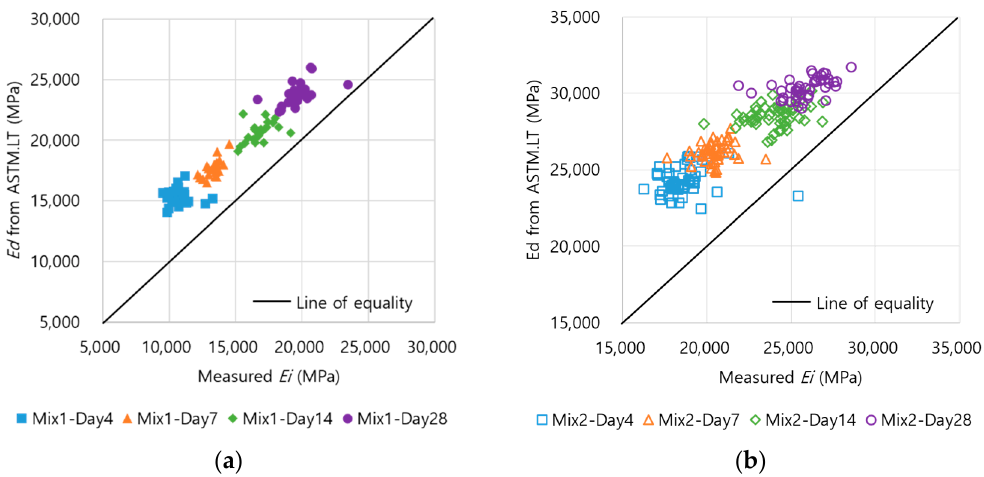
Figure 8. Comparison of Ed and Ei by ages and mixes according to ASTM.LT. ( a ) Mix 1 (20 MPa), ( b ) Mix 2 (40 MPa).